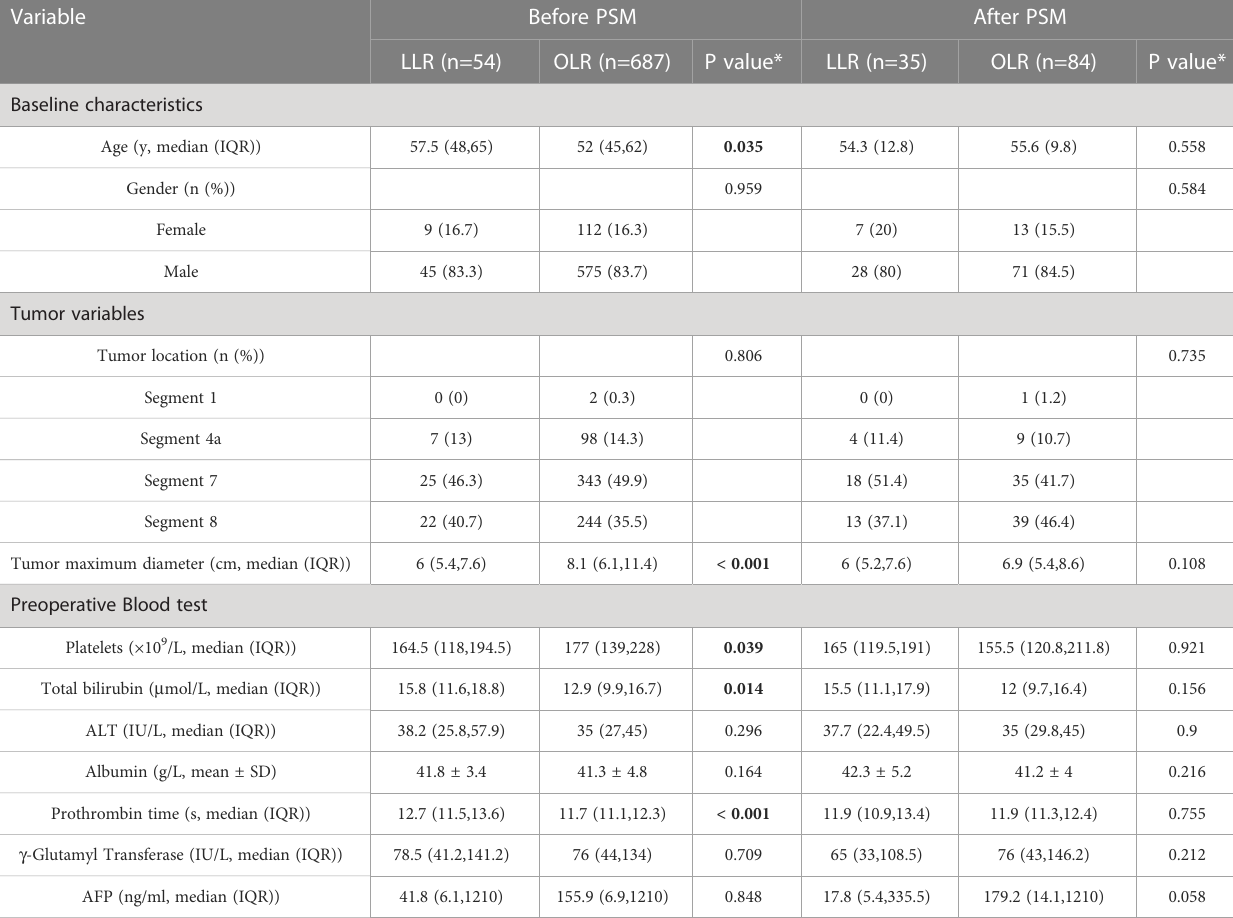
TABLE 1 Baseline characteristics of patients before and after propensity score matching. Variable Before